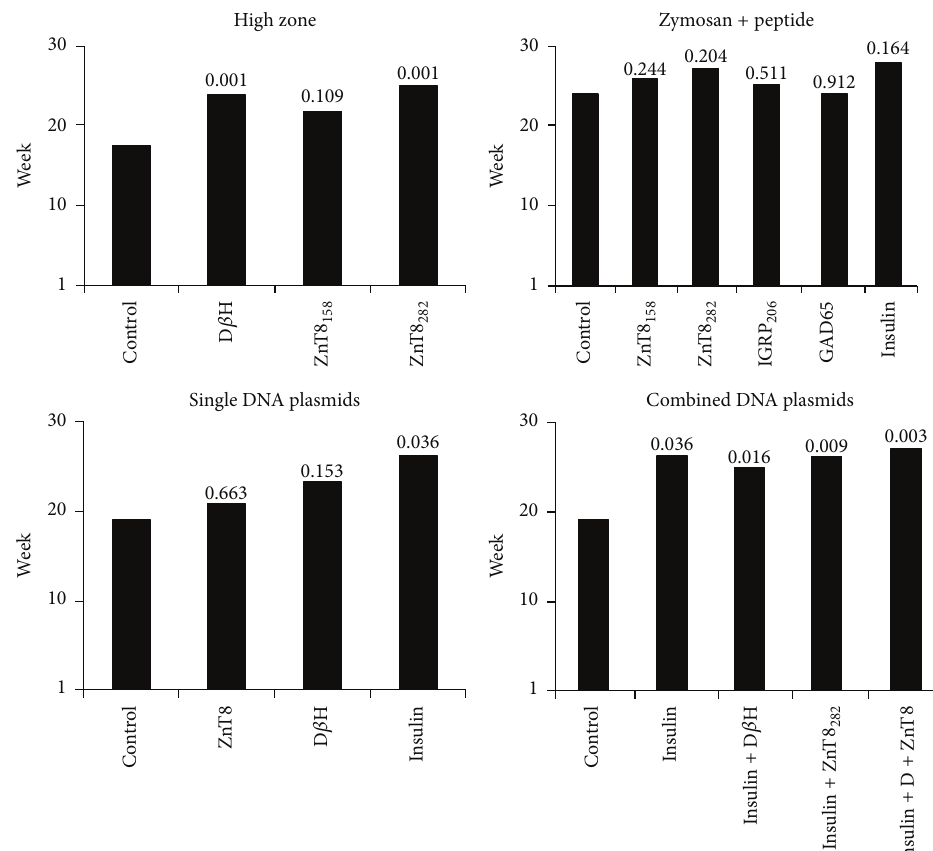
Figure 3: Median age to develop elevated blood glucose after various tolerizing therapies. Data shown in Figures 2(c) and 2(d) were analyzed using the Gehan-Breslow-Wilcoxon test for median age (week) to develop disease. All 𝑃 values are compared within an experiment to the control group and are shown above each bar. The number of mice in each experiment is described in the legend of Figure